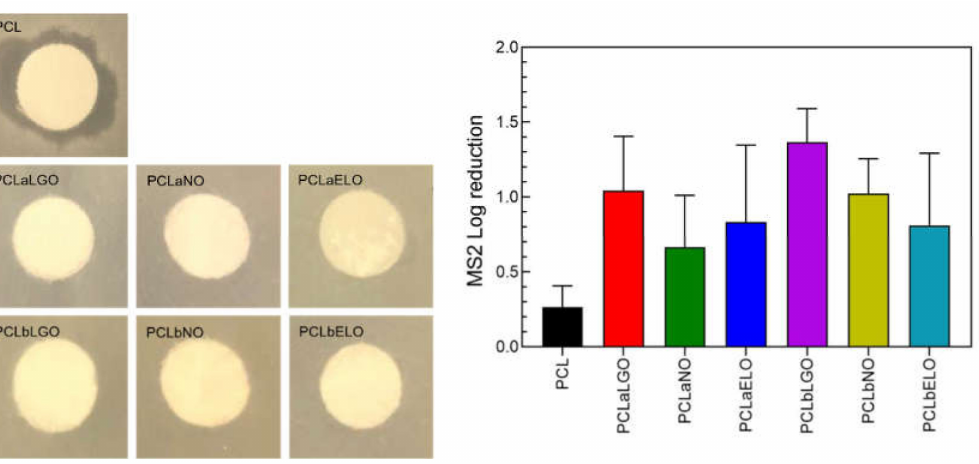
Figure 6. Inhibition of bacteriophage MS2 activity by unloaded and EOs-loaded PCL fibers examined via ( left ) mat permeability (24 h) and ( right ) direct contact inactivation (4 h). EOs diffusion from the mats to the agar plates was not observed during permeability testing. Interference of EOs on the host during contact inactivation experimentation was taken into consideration and accounted for in the present data. LGO and NO introduced a ≈ 2% and a ≈ 5% host-related influence, respectively, while ELO did not affect the